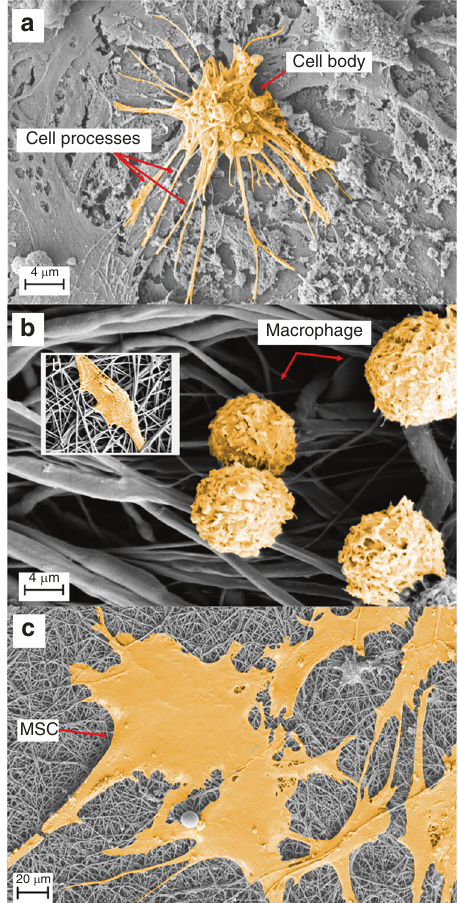
Fig. 2 Scanning electron microscopy (SEM) images of cultured cells in vitro. a Human osteocytes are stellate in shape and are found within the lacunae-canalicular system. The cell body varies in size between 5 and 20 µm in diameter and sits within the lacunae. Each cell body contains 40 – 60 cell processes, which are approximately 23 – 50 µm in length. Cell processes occupy the canaliculi system and establish a communication network. The cell-to-cell distance is approximately 20 – 30 µm. b Image demonstrating rounded M0 murine macrophages, approximately 10-20 µm in size. When activated toward a pro- (M1) or anti-in fl ammatory (M2) phenotype, cytoplasmic extensions appear, and cell size increases with elongation of the cell body associated with the M2 phenotype ( inset b ). c Human mesenchymal stem cells (MSCs) are a hetero- geneous cell population that are typically large, fl at and spindle shaped. MSCs range between 15 and 40 µm in